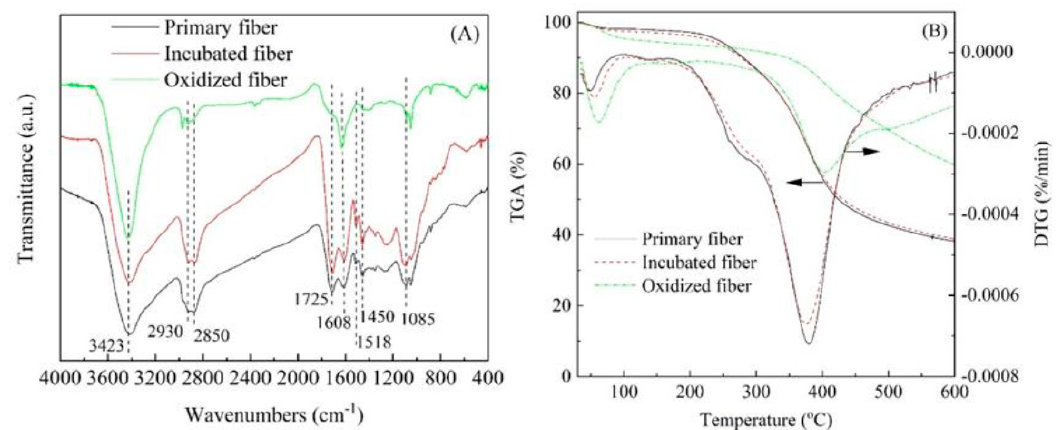
Figure 2. The FTIR spectrums ( A ) and TGA curves ( B ) of primary fiber, incubated fiber (10% acid solutions) and the oxidized fiber with the heating rate of 5 °C/min.